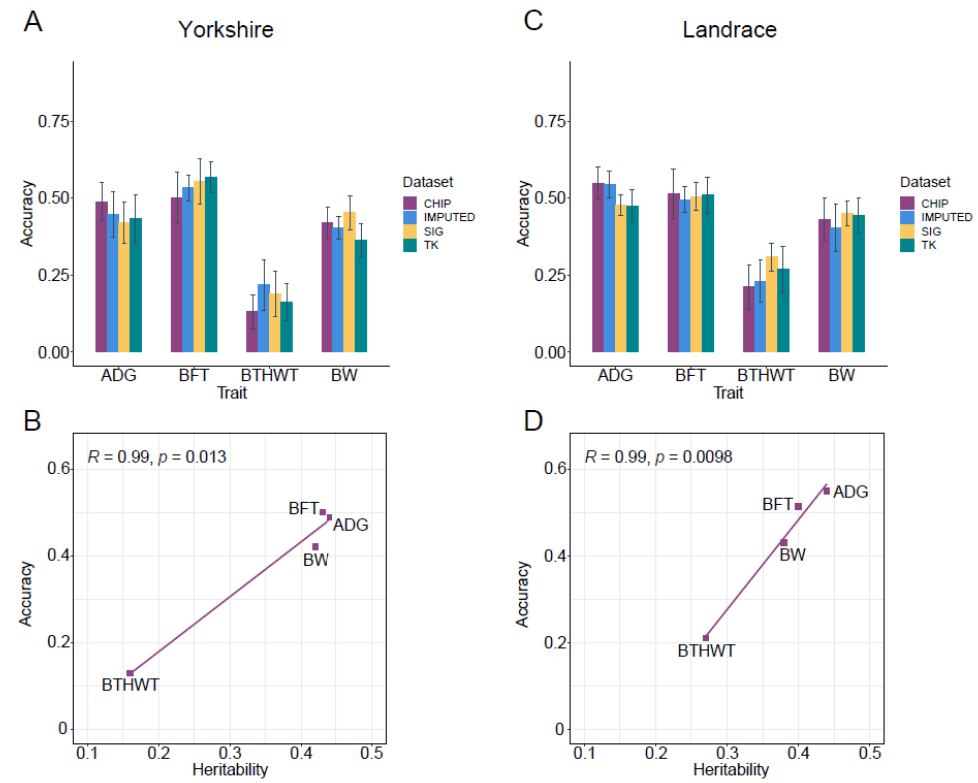
Figure 5. Genomic prediction accuracies (GPA) of GS using three sets of SNPs for average daily gain (ADG), backfat thickness (BFT), birth weight (BTHWT) and body weight (BW). Results for Yorkshire and Landrace are in ( A , C ), respectively. CHIP and IMPUTED represent GPAs estimated by GBLUP model based on all loci in 60K chip and imputed data, respectively. SIG represents GPAs estimated by GBLUP model based on the combination of significant variants from CL_GWAS, CB_GWAS and IL_GWAS. TK represents GPAs estimated by two-kernel based GBLUP based on the combination of significant variants from CL_GWAS, CB_GWAS and IL_GWAS. ( B , D ) represent correlation fitting curves between heritabilities and GPAs of 60K chip SNPs in Yorkshire and Landrace, respectively. Error bars represent the standard deviation of the accuracy across replications.